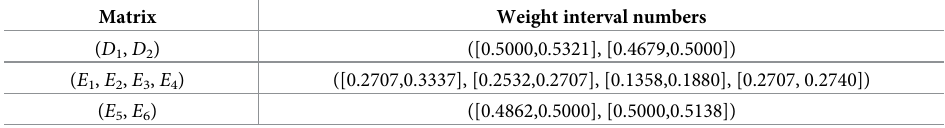
Table 9. Weight interval number of dynamic competency indices by improved method.